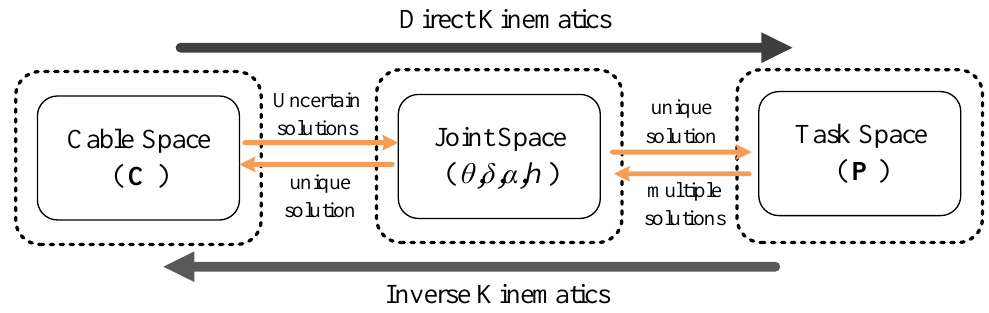
Figure 8. Multilevel kinematic mappings of the cable-driven continuum arm.